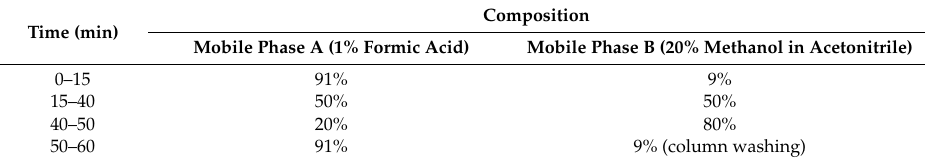
Table 2. Gradient used for separations amino acids, biogenic amine, and bioactive peptides. Time